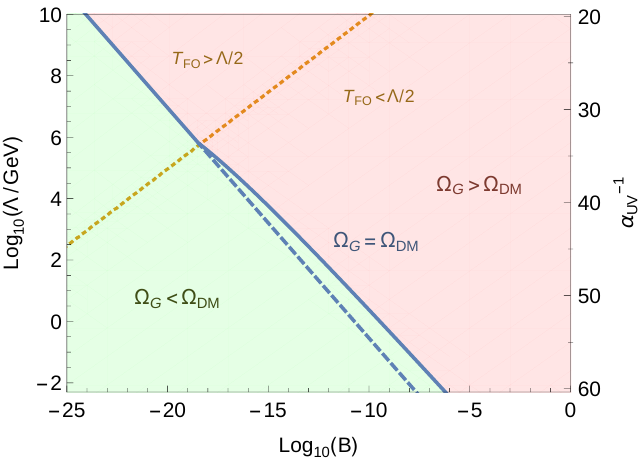
Figure 1 . The viable glueball DM parameter space for an SU (3) hidden sector in a model with a high reheat temperature and standard cosmology. B parameterises the relative strength of in(cid:13)aton decays to the glueball and visible sectors, de(cid:12)ned in eq. (2.2), and (cid:3) is the hidden sector con(cid:12)nement scale. Green regions have an under abundance of glueball dark matter, and models on the solid blue line have the observed DM relic density. The results obtained ignoring 3 ! 2 interactions are shown in dashed blue. Below (cid:3) ’ 0 : 1 GeV late time DM self interactions are signi(cid:12)cant and such models are probably ruled out. Above and left of the orange line 3 ! 2 interactions freeze out when the glueball temperature is > 1 (cid:3). The UV values of the hidden sector gauge couplings (cid:11) UV 2 de(cid:12)ned at 10 16 GeV corresponding to (cid:3) are also shown, assuming the theory is supersymmetric above 10 6